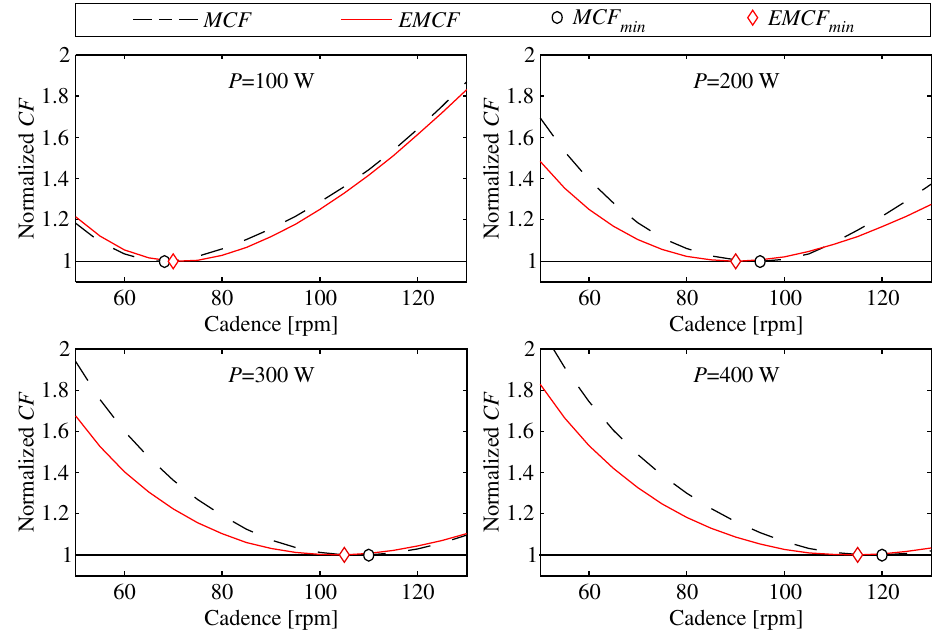
Figure 5. MCF and EMCF at different power outputs for a cyclist with 70kg mass and 1.75m